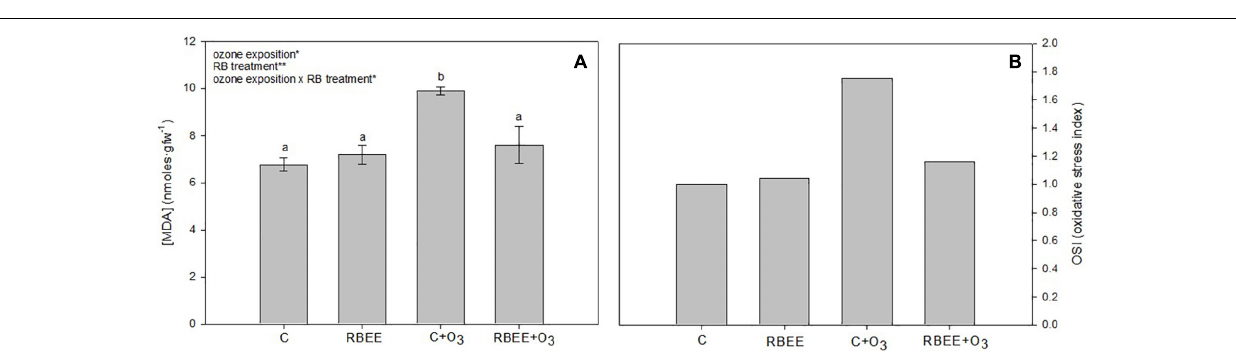
FIGURE 4 | Malondialdehyde concentration (MDA) (A) and oxidative stress index (OSI) (B) in leaves of pepper plants in response to two conditions of ozone (O 3 ) (0 and 100 ppm) under a treatment without and with rice bran enzymatic extract (RBEE). Values represent mean ± SD, n = 5. Different letters indicate means that are significantly different from each other (two-way ANOVA, O 3 exposition × RBEE treatment; HSD test, P < 0.05). O 3 exposition, RBEE treatment, and O 3 exposition × RBEE treatment in the corner of the panels indicate main or interaction significant effects (* P < 0.01; ** P <